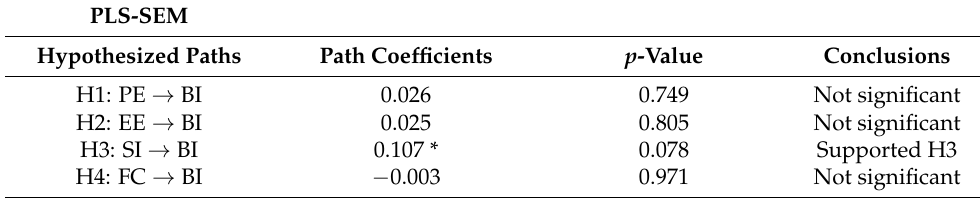
Table 5. Estimation results of the proposed UTAUT